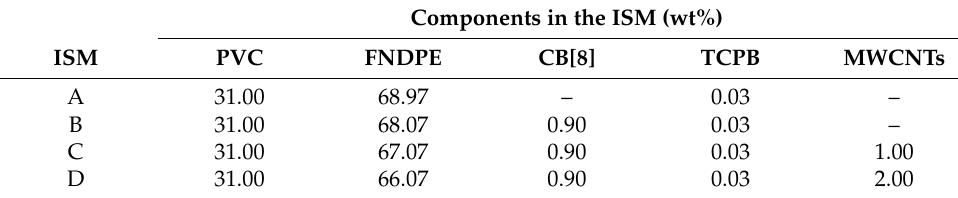
Table 1. Ion-selective membranes (ISMs)